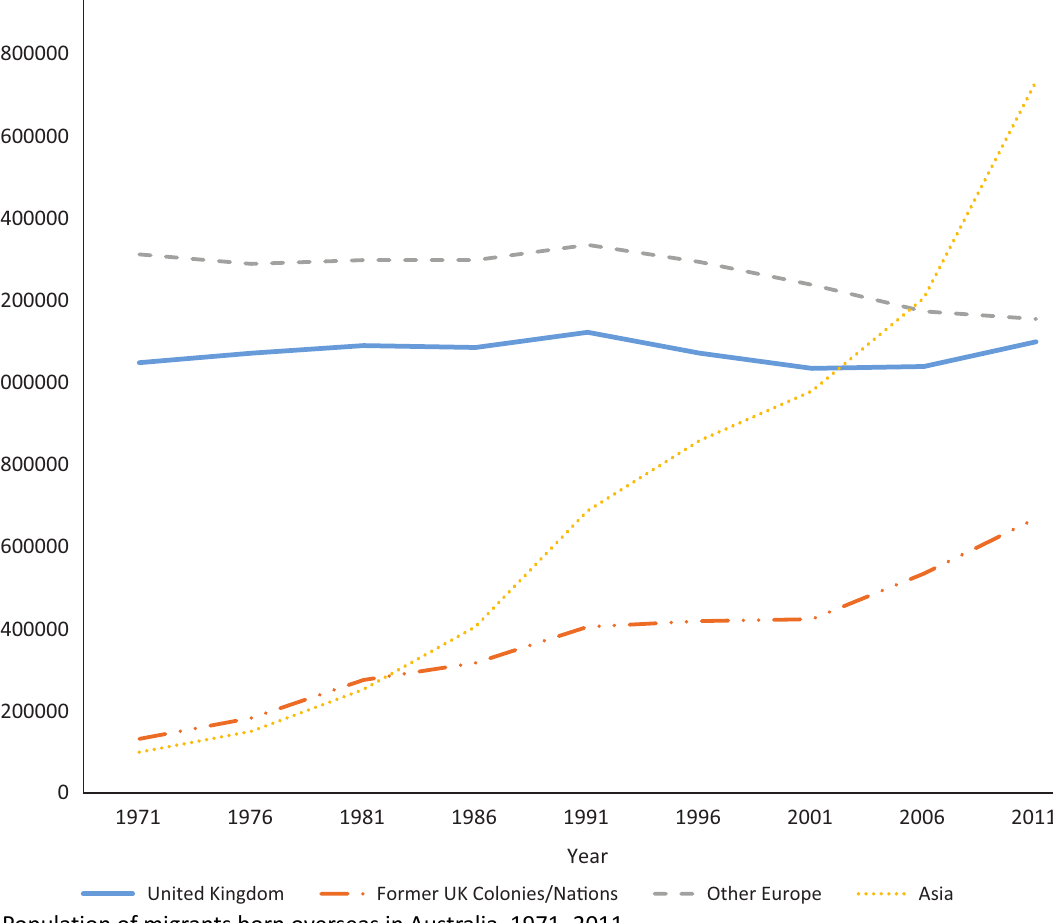
Figure 1. Population of migrants born overseas in Australia, 1971–2011. Table 1. Population of migrants to Australia from main source countries in Asia, percent,